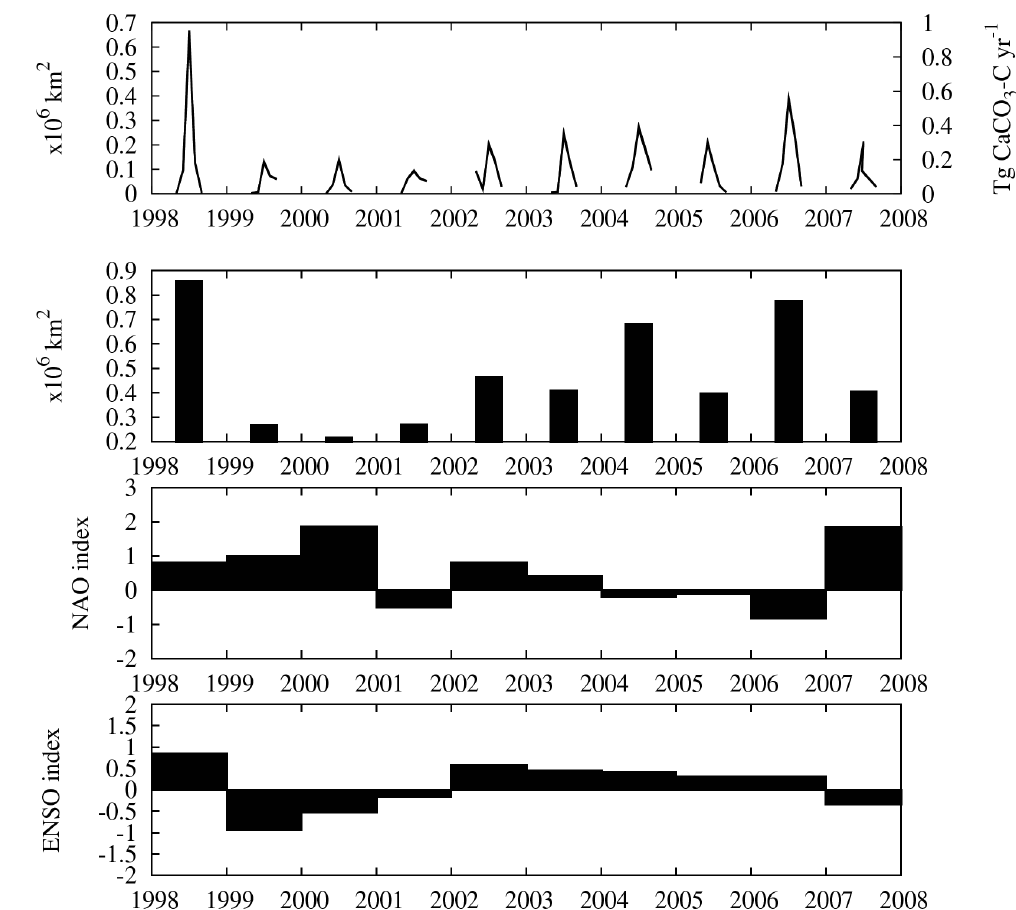
Fig. 2. Time series data (1998–2007). (a) Monthly Emiliania huxleyi surface coverage and CaCO 3 -C production for April to August of each year using the mid-range parameter set; (b) yearly total (sum of April to August) of surface coverage for each year; (c) mean NAO index for each year and (d) mean multivariate ENSO index for each